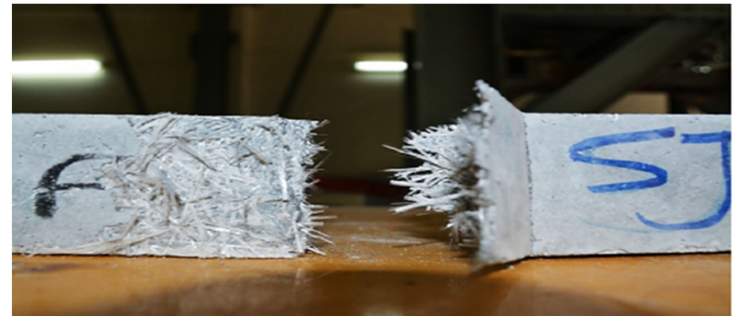
Figure 5. Failure of GF-reinforced beam: Permission of use from Elsevier [33].